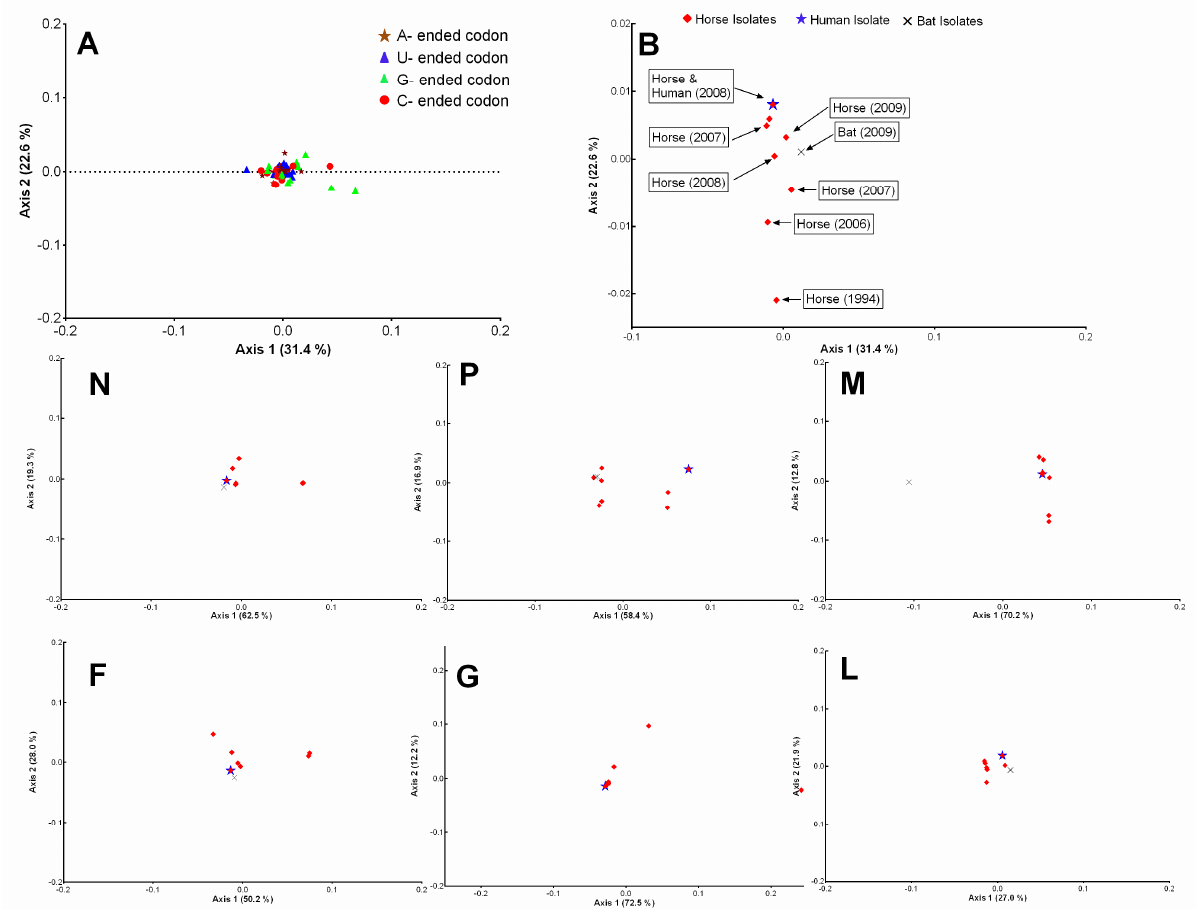
Figure 3. Codon usage variations in the coding sequences of HeV. Correspondence analysis (COA) was performed on the RSCU of codons ( A ) and complete coding sequences of HeV isolates ( B ) and plotted on the first two-main-axes. The COA analysis of different protein-coding sequences (N, P, M, F, G, L) of HeV was also plotted on the first two-main-axes. The different base-ended codons and host-wise HeV isolates were color labeled.